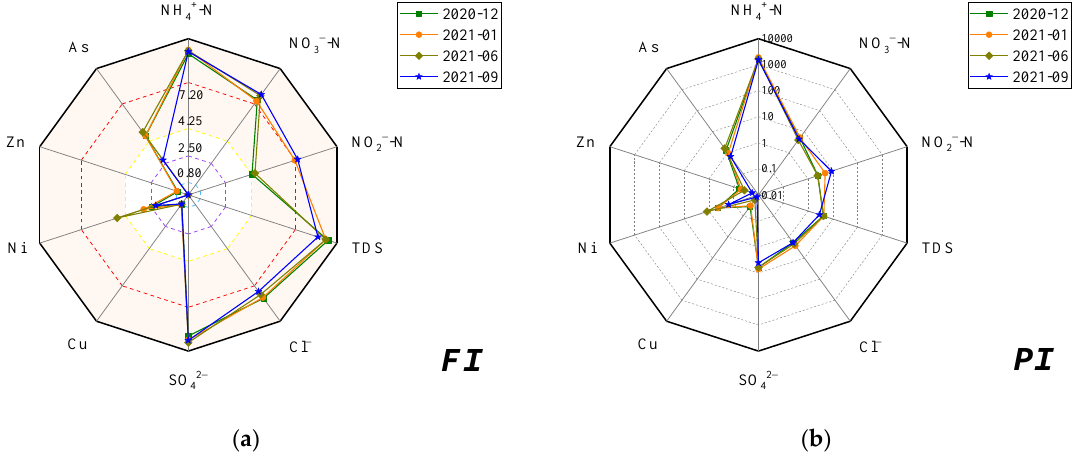
Figure 3. The comprehensive scores for potential pollutants in groundwater: FI values by the Grading method ( a ) and PI ( b ) values by the Nemerow index method.